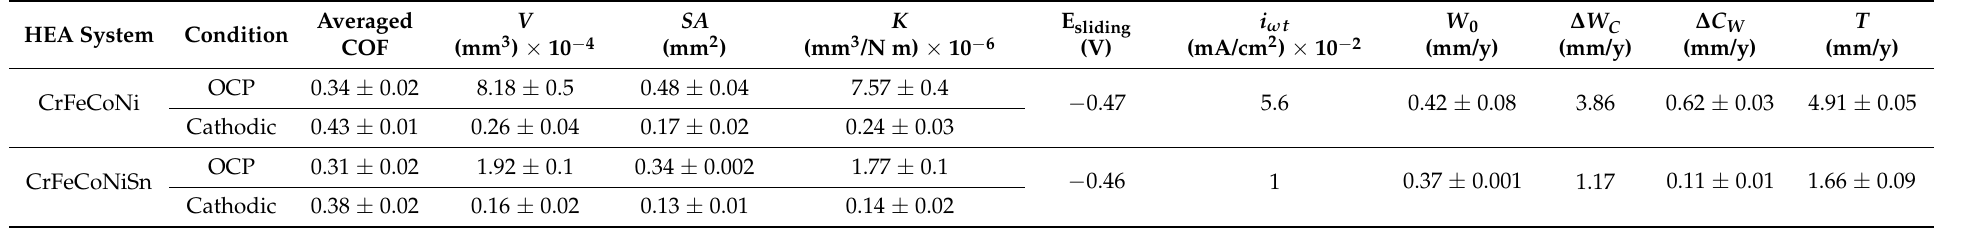
Table 5. Tribological and tribocorrosion parameters for CrFeCoNi and CrFeCoNiSn alloys tested in 0.6 M NaCl solution at ambient